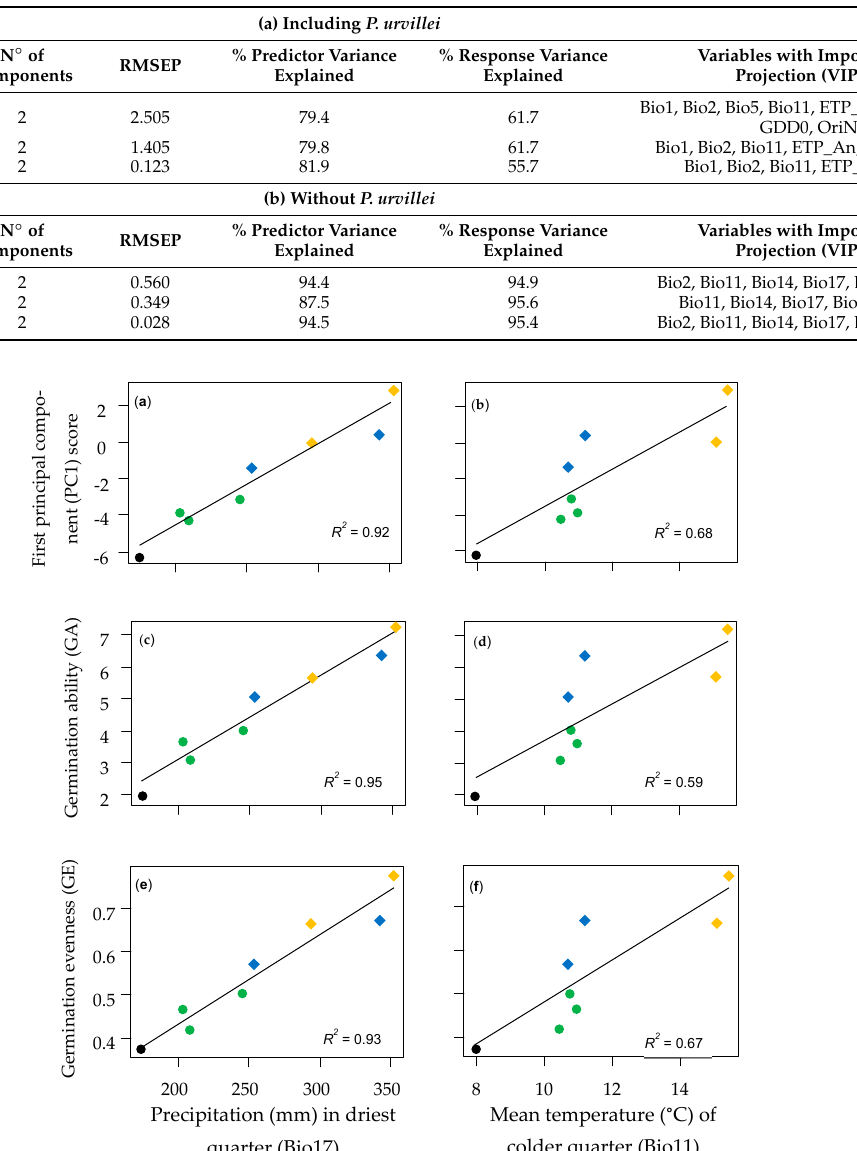
Figure 3. Linear regressions with precipitation in the driest quarter ( a , c , e ) and with the mean temperature of the colder quarter ( b , d , f ) for three germination variables: First principal component (PC1) score from PCA ( a , b ), germination ability (GA) ( c , d ), and germination evenness (GE) ( e , f ). Colours identify the species: black = P. dasypleurum , green = P. flavescens , blue = P. vacarianum , and orange = P. plurinerve . Genotypes of P. urvillei were not included. Southernmost distributed species are represented with circles and northernmost species with diamonds. Mean values for each genotype of the four species were used. The determination coefficient ( R 2 ) for each regression is reported.